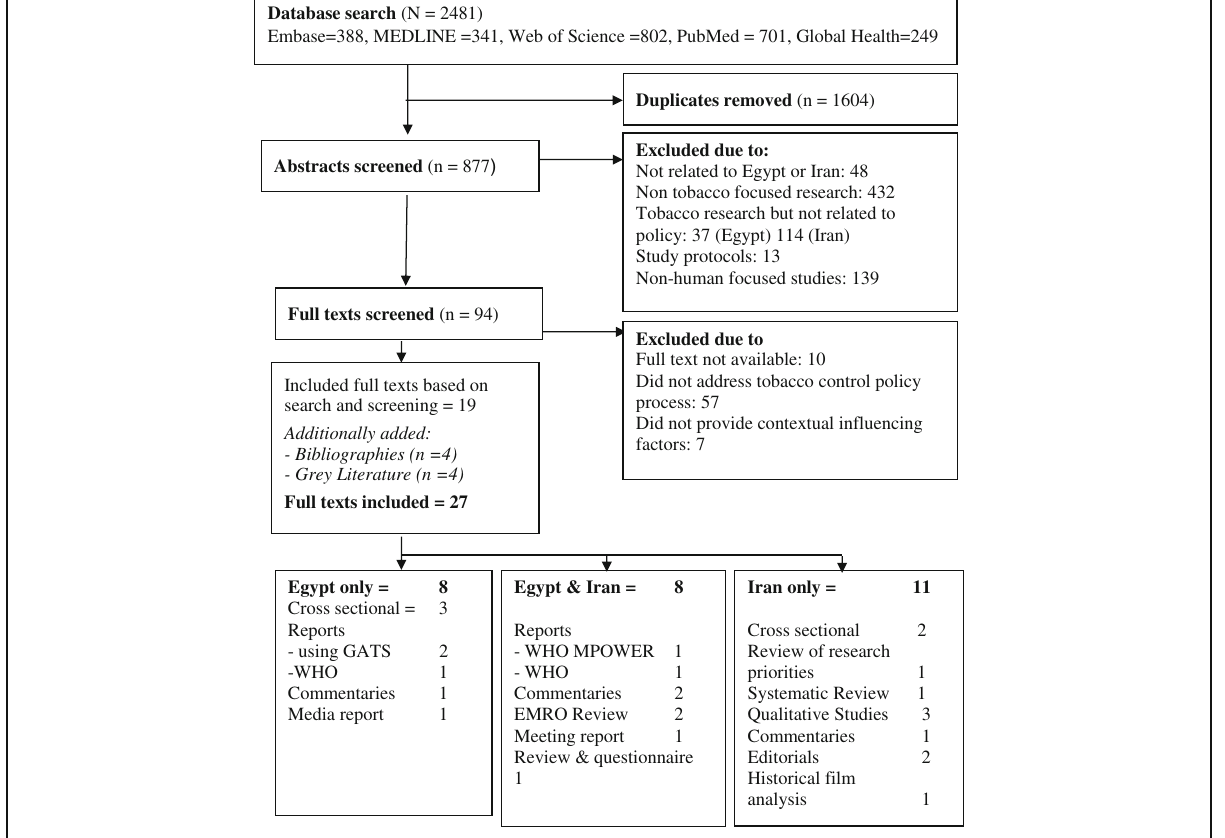
Fig. 1 Literature review flow diagram adapted from